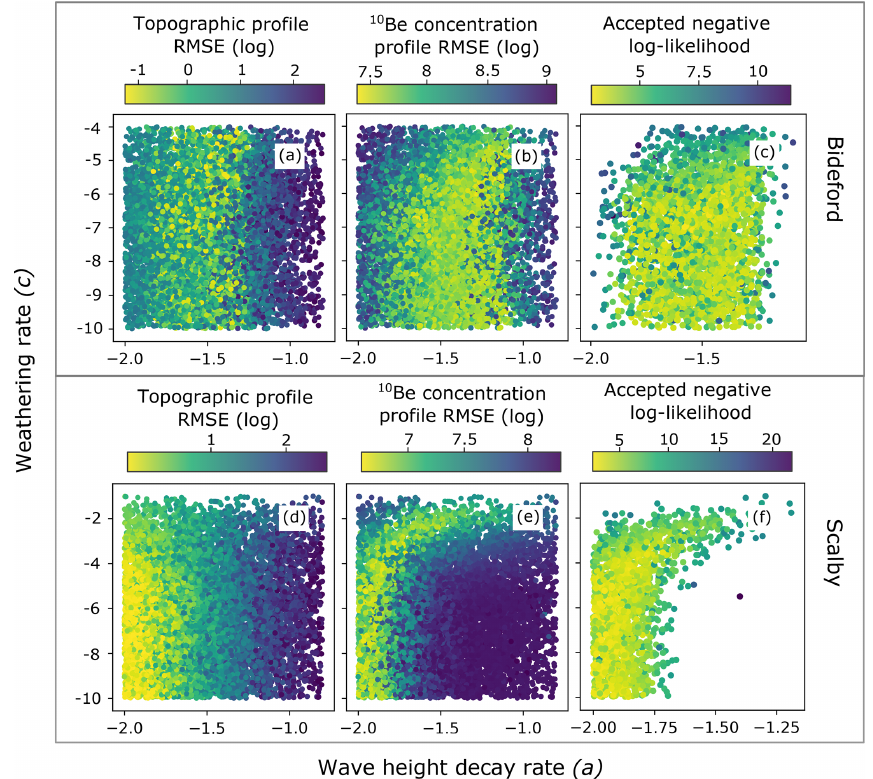
Figure 9. Objective function results for the wave height decay rate ( y ) and weathering rate ( K ) parameters constructed from 50%–50% weighted MCMC analysis results for the Bideford and Scalby sites. The topographic profile RMSE (a, d) and 10 Be concentration profile RMSE (b, e) objective function spaces are constructed from all 10000 samples visited in the MCMC analysis for Bideford and Scalby, respectively. The combined likelihood objective function space (c, f) is constructed just using the accepted samples from the MCMC analysis. Dark blue corresponds to the worst samples that have the highest RMSE and negative log-likelihood scores, while bright yellow corresponds to the best samples that have the lowest RMSE and negative log-likelihood